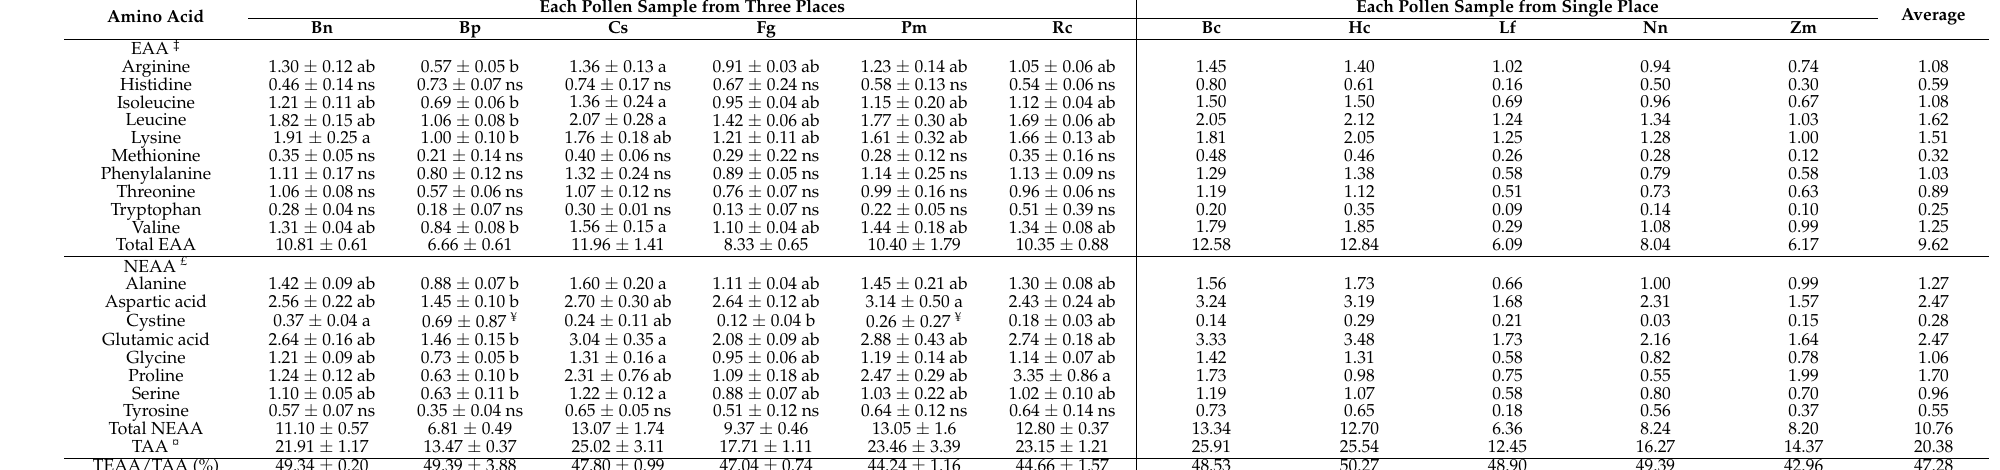
Table 4. Amino acid composition of bee pollen samples (g/100 g dry mass) †